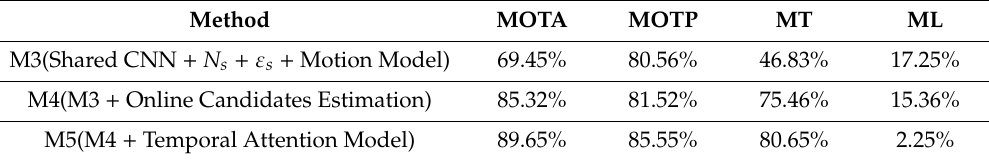
Table2. AnalysisoftheO ffl ineCandidatesRecommendationandMotionModelusingtheKITTIdataset. Table 2. Analysis of the Offline Candidates Recommendation and Motion Model using the KITTI dataset.